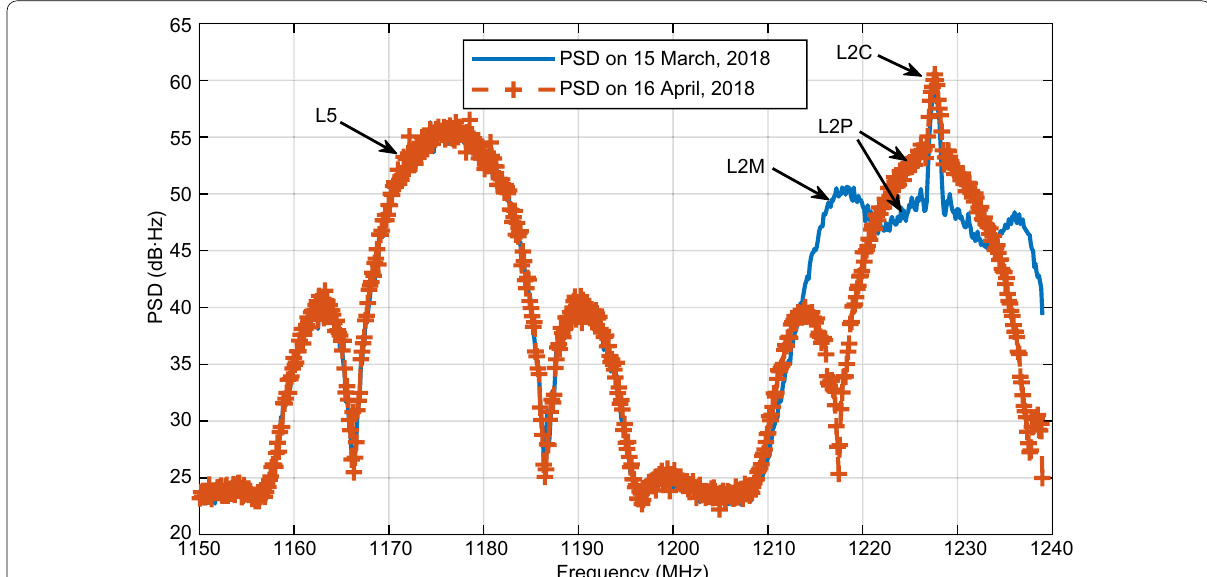
Fig. 7 The PSD of GPS Block IIF-10 L5 and L2 signal. The PSD is observed from samples of high-gain